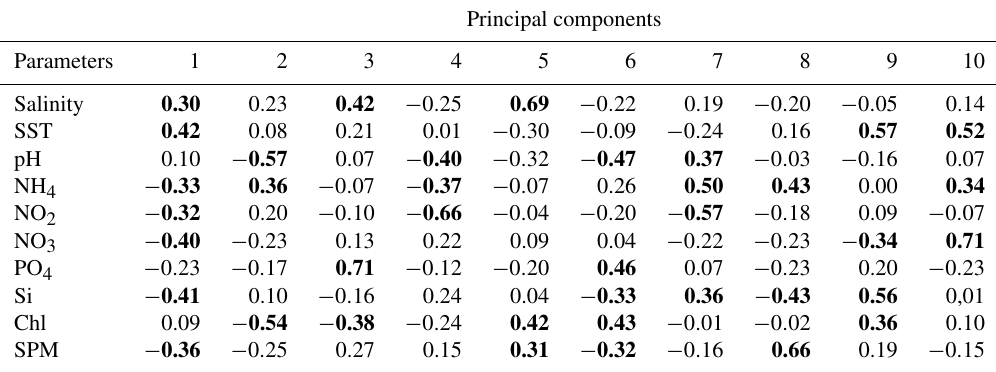
Table A2. PCA coefficients of principal components for the tested physical and hydrochemical parameters, Sylt Roads time series, and seasonal averages (1984-2019). Coefficients >0,3 or <-0,3 are shown in